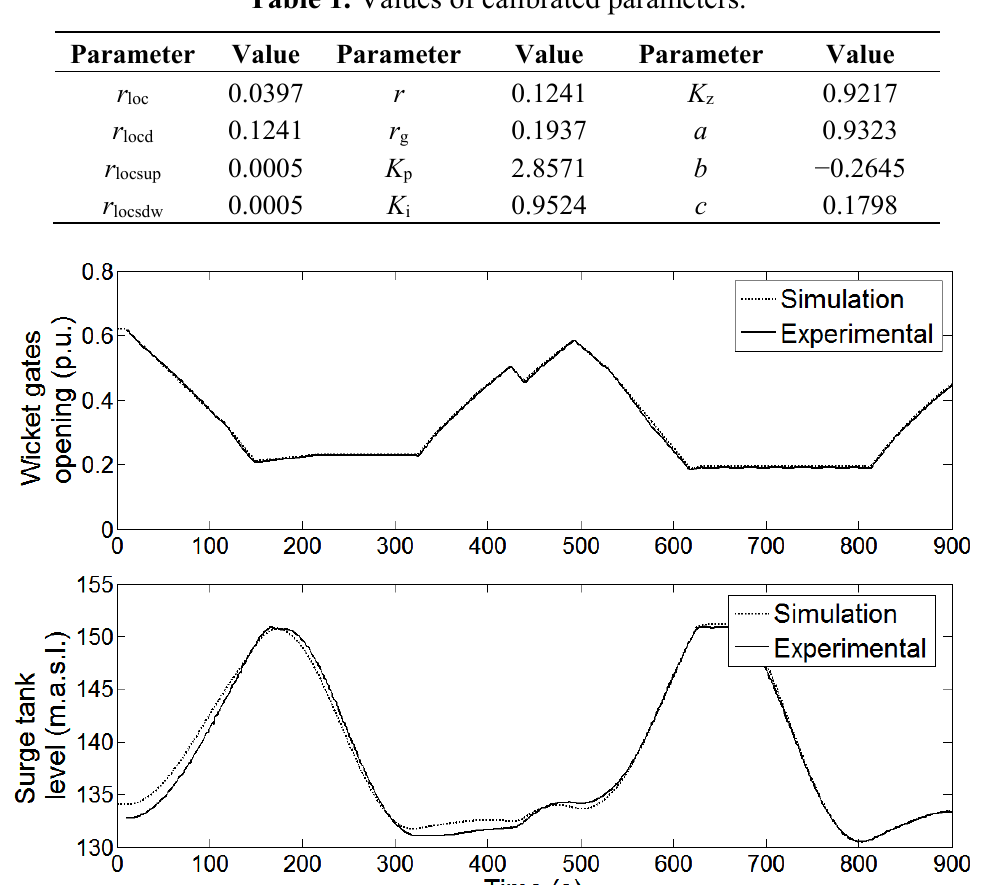
Table 1. Values of calibrated parameters.